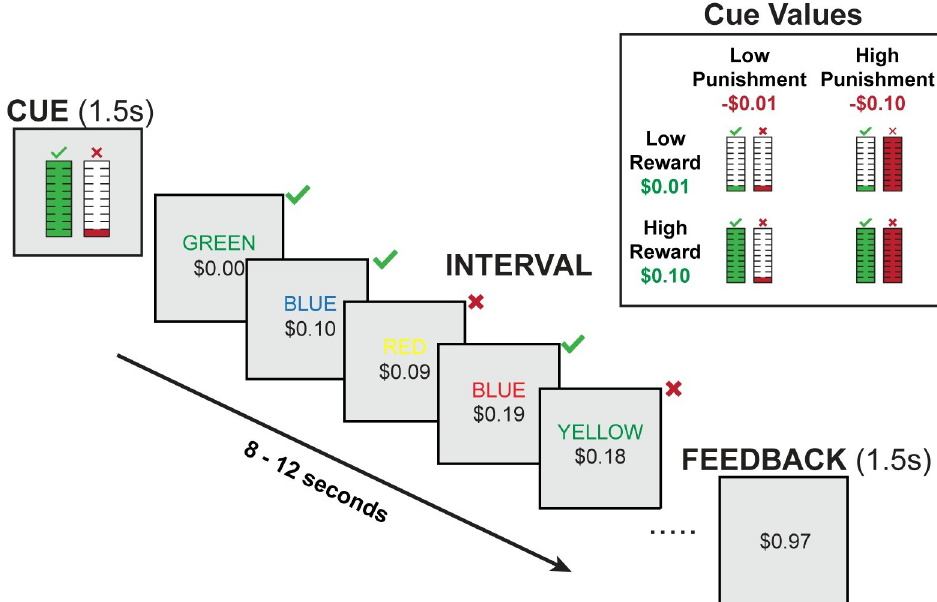
Fig 1. Interval-Based Incentivized Cognitive Control Task. At the start of each interval, a visual cue indicates the amount of reward (monetary gain) for correct responses and the penalty amount (monetary loss) for incorrect responses within that interval. Participants can complete as many Stroop trials as they want within that interval. The cumulative reward over a given interval is tracked at the bottom of the screen. Correct responses increase this value, while incorrect responses decrease this value. At the end of each interval, participants are told how much they earned. The upper right inset shows the cues across the four conditions.